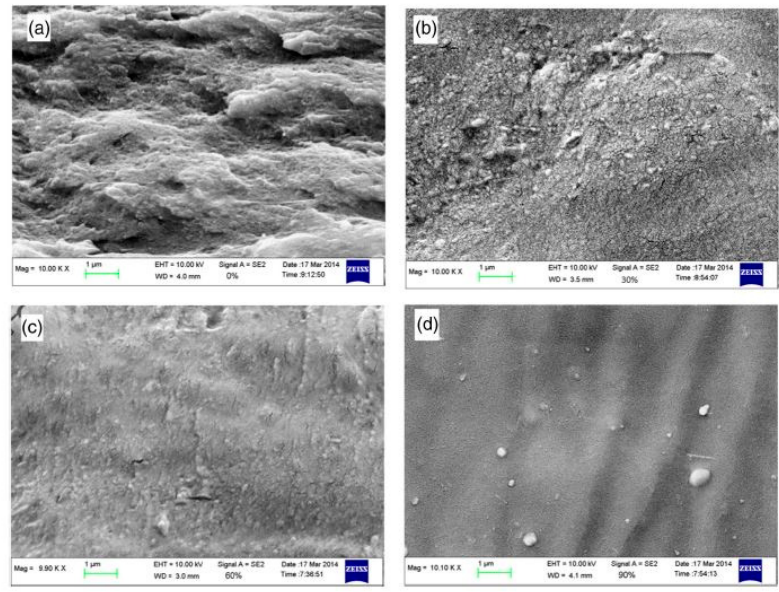
Figure 18. SEM micrographs of CS membrane with the addition of ( a ) 0 wt.%, ( b ) 30 wt.%, ( c ) 60 wt.%, and ( d ) 90 wt.% [Bmim][OAc] [236]. Copyright 2015, reproduced with permission from Elsevier